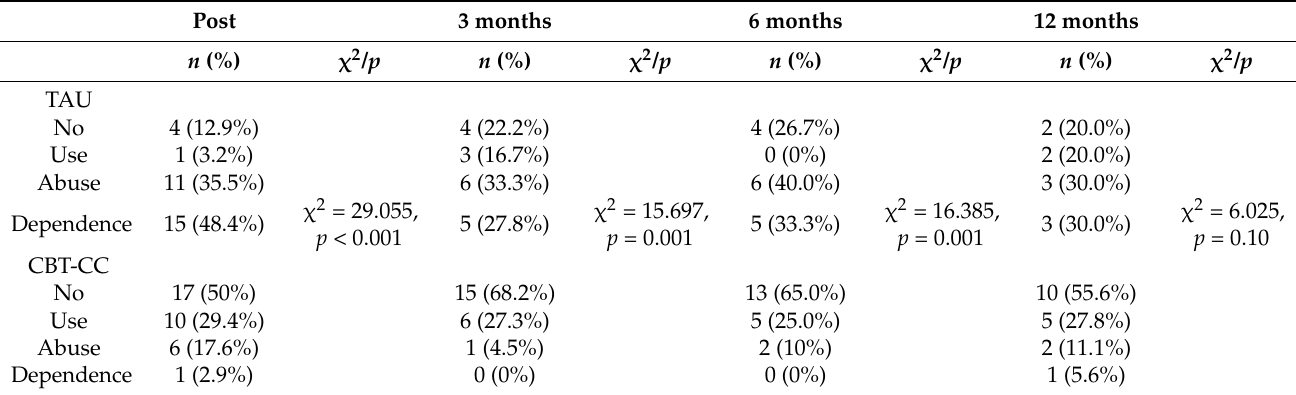
Table 3. Cannabis use severity at